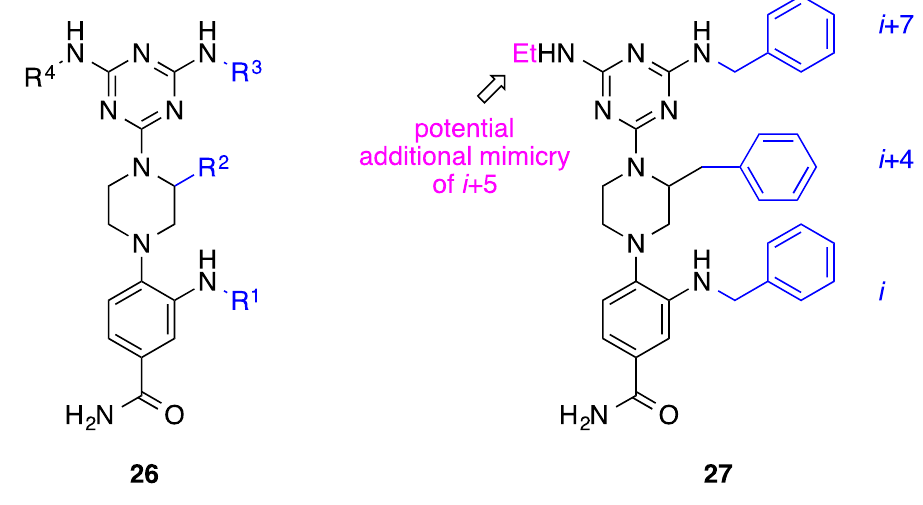
Figure 11. A phenyl-piperazine-triazine helix mimetic disrupts the Bim–Mcl-1 PPI. Synthetic strategies to vary the ethyl group should allow the additional mimicry of the i + 5 position on the opposing